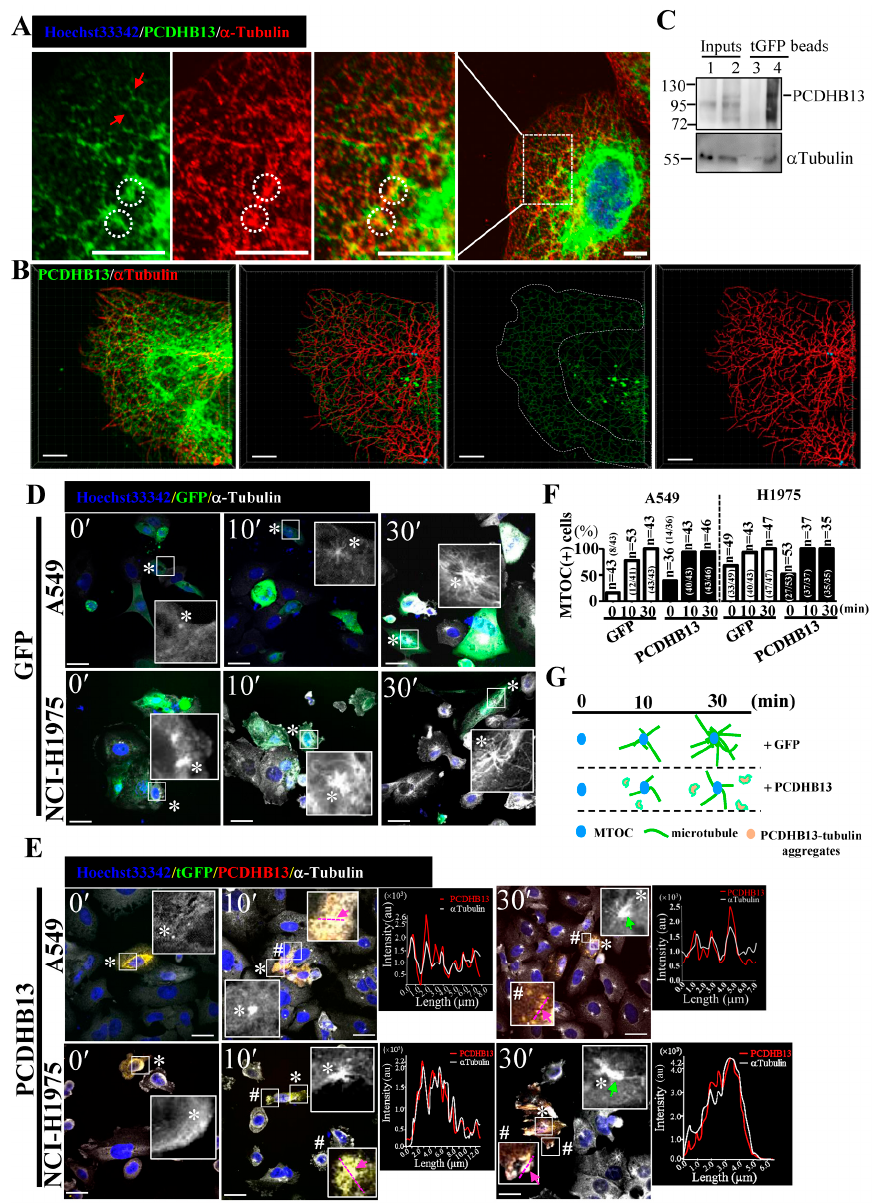
Figure 4. PCDHB13 disrupts microtubule dynamics in NSCLC cells. ( A ) Cellular localization of PCDHB13 in A549 cells. Cells were stained with PCDHB13 (green) and α -Tubulin (red). Hoechst33342 was used to stain nuclei (blue). Boxed regions are magnified in the panels to the right. Red arrows indicate the filamentary structure of PCDHB13. White circles indicate the cellular aggregates formed by PCDHB13 and α -Tubulin. Bar: 20 μ m. ( B ) PCDHB13 and α -Tubulin are shown in red and green, respectively. Cytoskeletal projections of each protein were simulated by Imaris software. Yellow color indicates colocalization of PCDHB13 and α -Tubulin. Bar: 8 μ m. ( C ) A549 cell